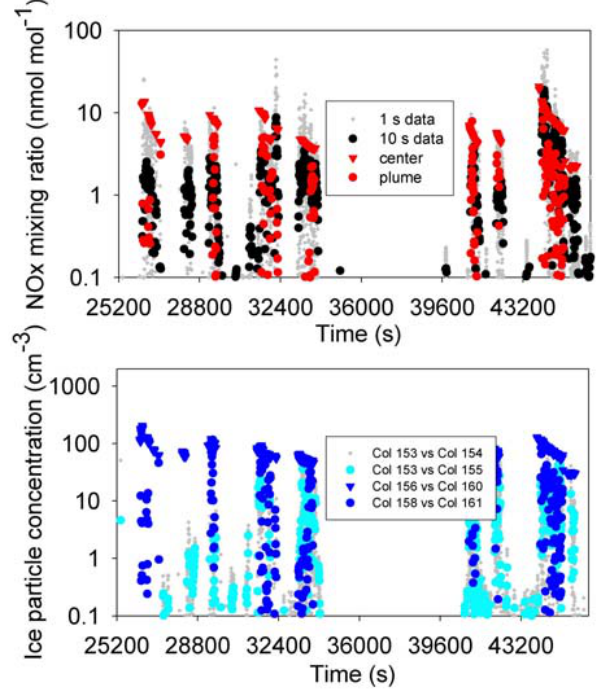
Fig. 8. Comparison of CoCiP model results to contrail observations during two flights on 19 November 2008. Upper panel: NOx mix- ing ratio versus Falcon flight time. Measured data (grey and black dots) and computed results (red circles: along computed flight path; red triangles: on the plume axis). Lower Panel: Concentration of ice particles larger than 1µm versus Falcon flight time. Measured data (grey and cyan dots) and computed results (blue circles: along computed flight path; blue triangles: on the plume axis).